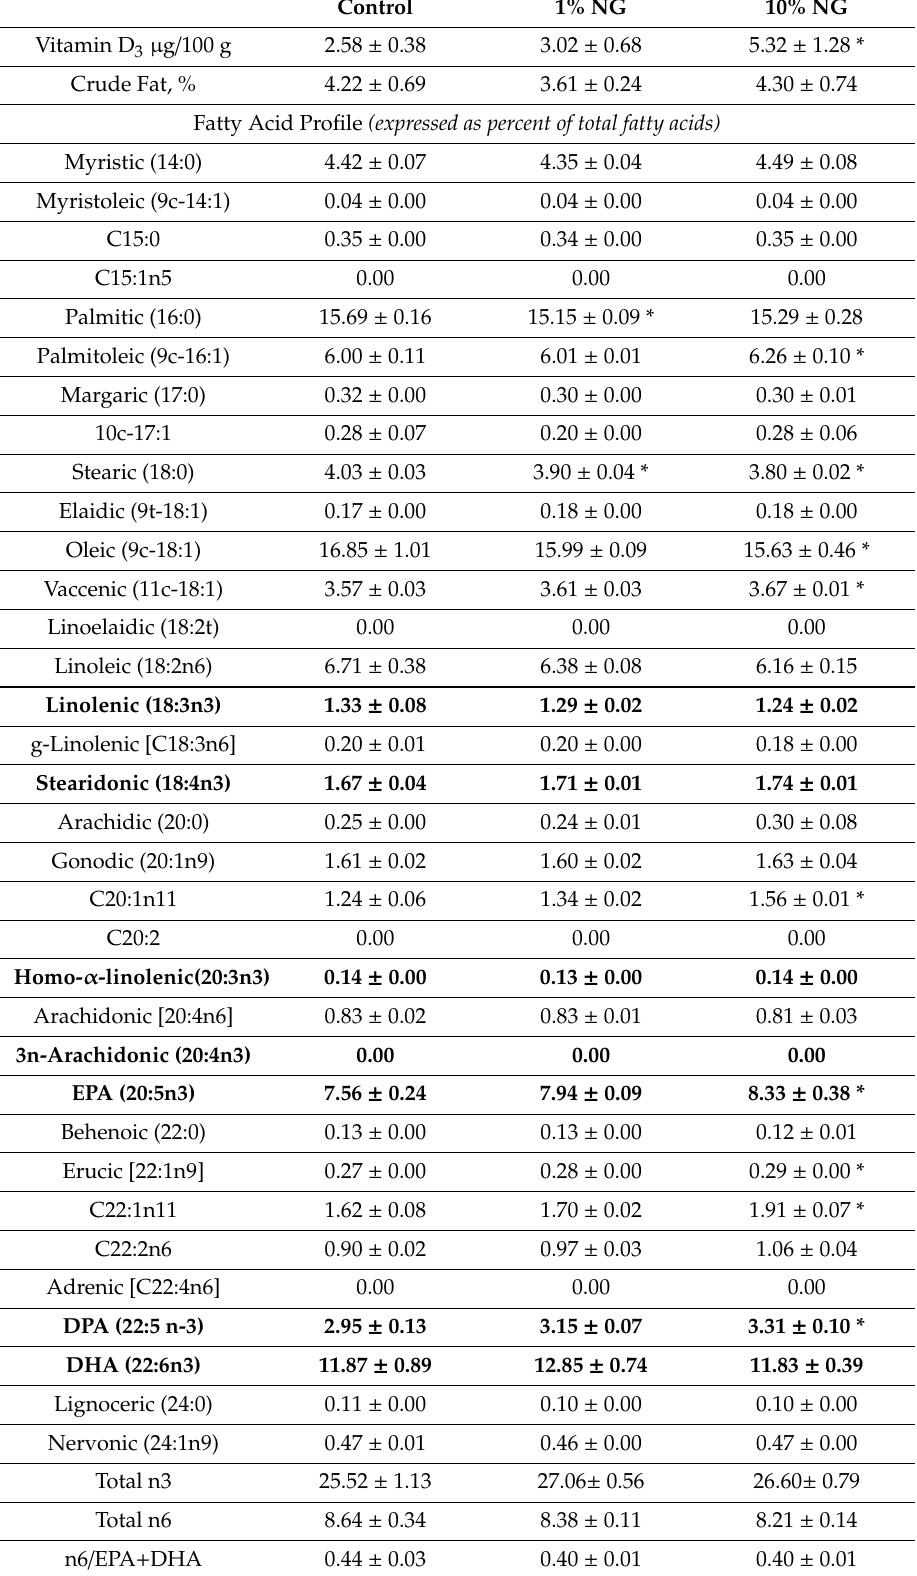
Table 8. Salmon meat fatty acid and vitamin D 3 composition after 49 days of feeding the experimental